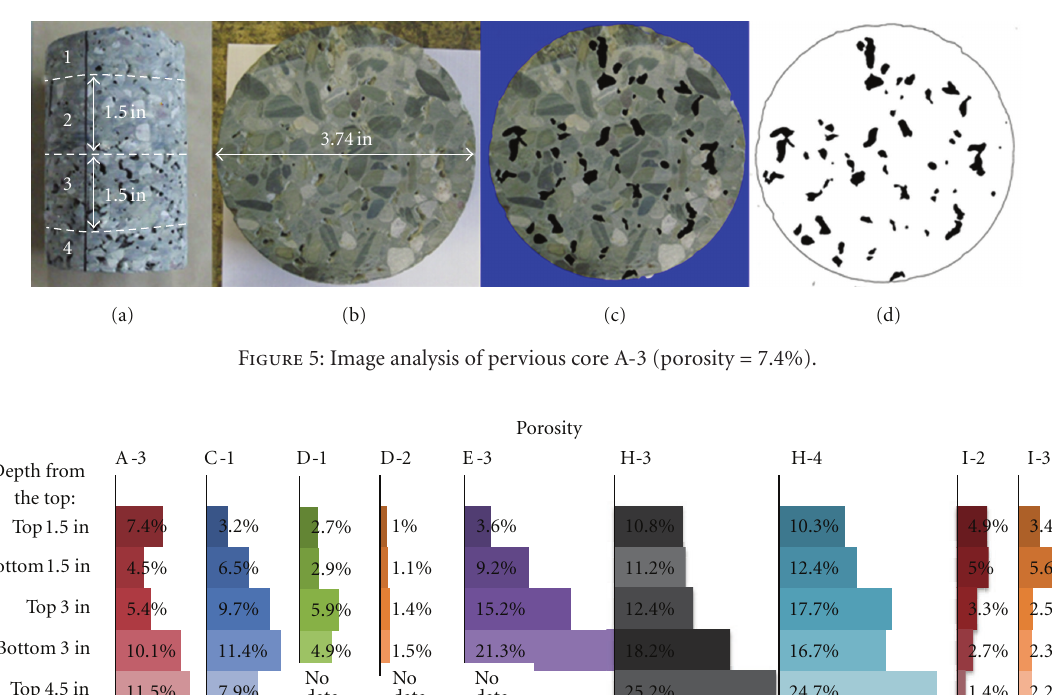
diameter concrete cylinder mold with a 22 mm hole